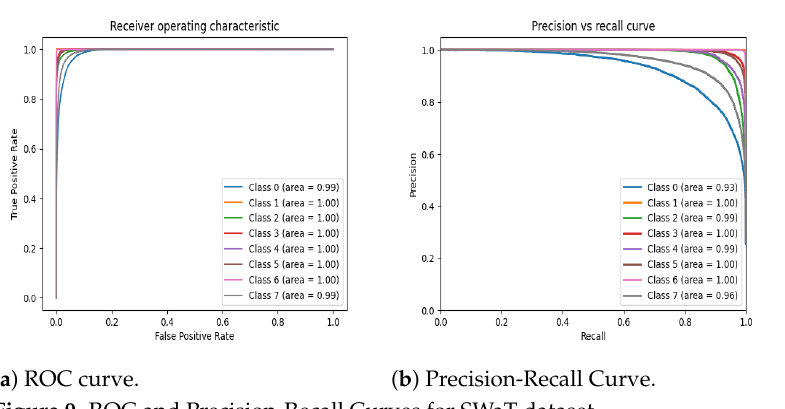
Figure 9. ROC and Precision-Recall Curves for SWaT dataset.